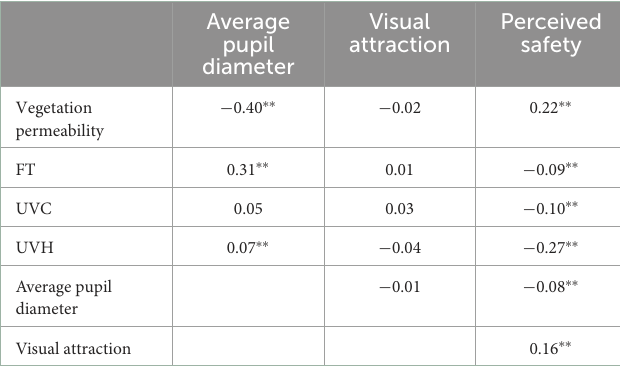
TABLE 4 Correlation test between forest stand attributes and participant’s visual